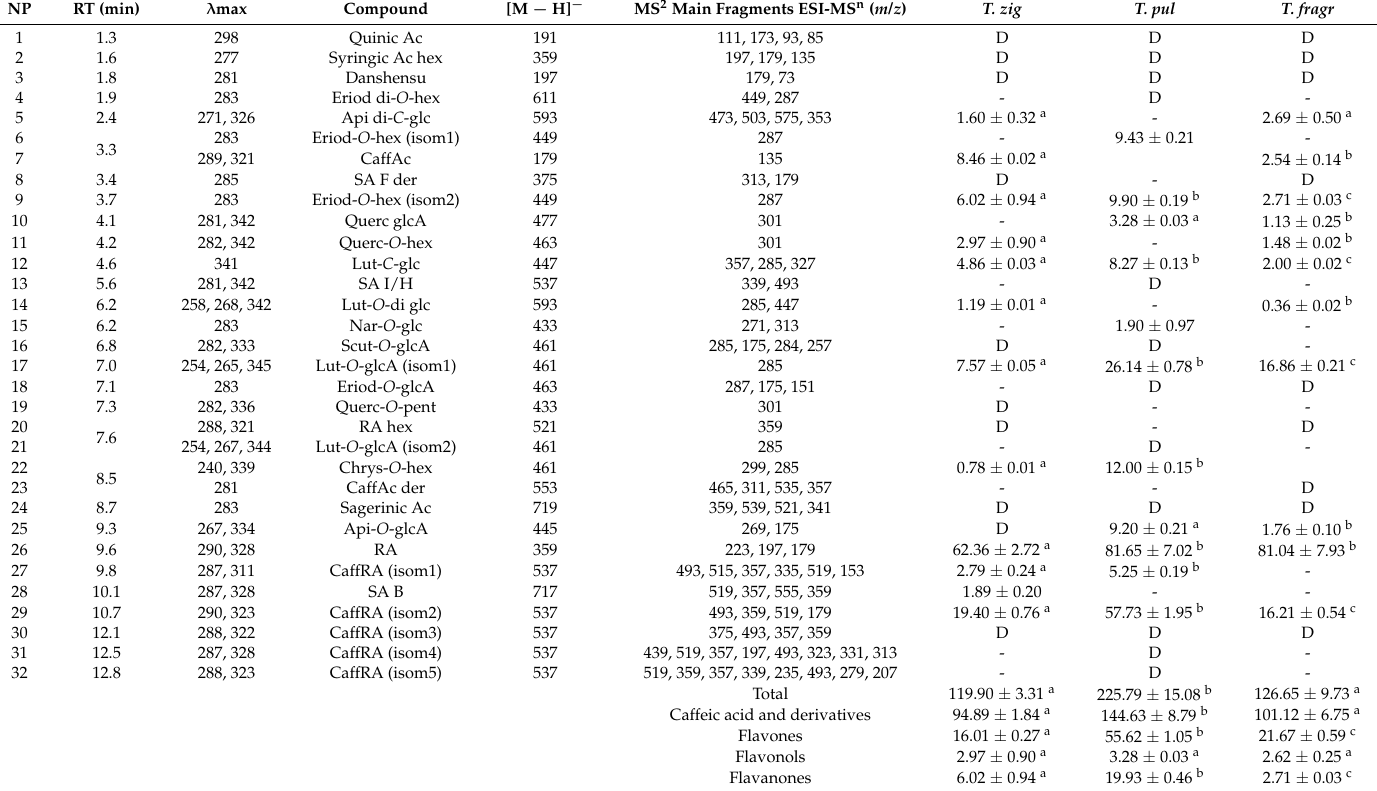
Table 3. Identification and quantification of the compounds in the aqueous extracts of T. zygis , T. pulegioides and T. fragrantissimus by UHPLC-DAD-ESI-MS n